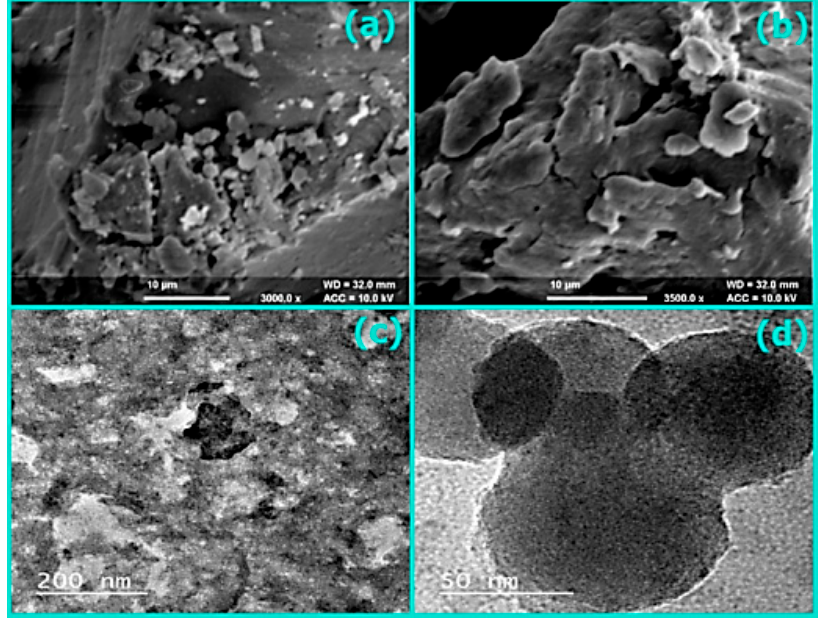
Figure 2. SEM images ( a ) FeSP and ( b ) SDS/FeSP, TEM images of ( c , d ) SDS/FeSP nanocomposite [25].